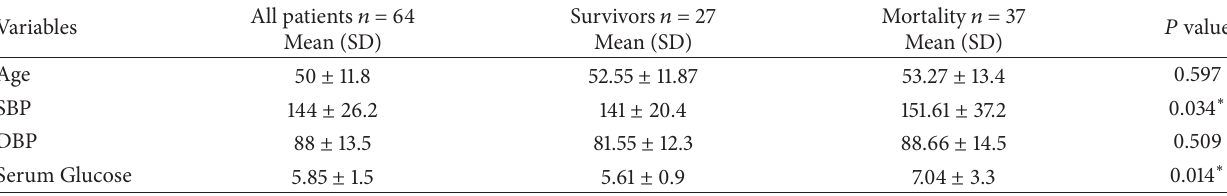
Table 2: Age, systolic blood pressure, diastolic blood pressure, and serum glucose of rebleeding patients after aneurysmal SAH. Variables